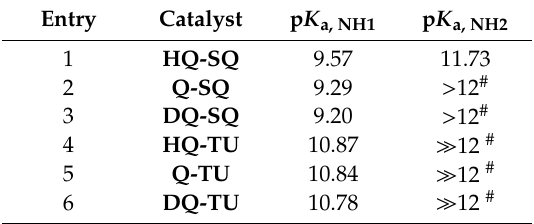
Table 2. The p K a values of acidic squaramide or thiourea units measured in water. Entry Catalyst p K a,